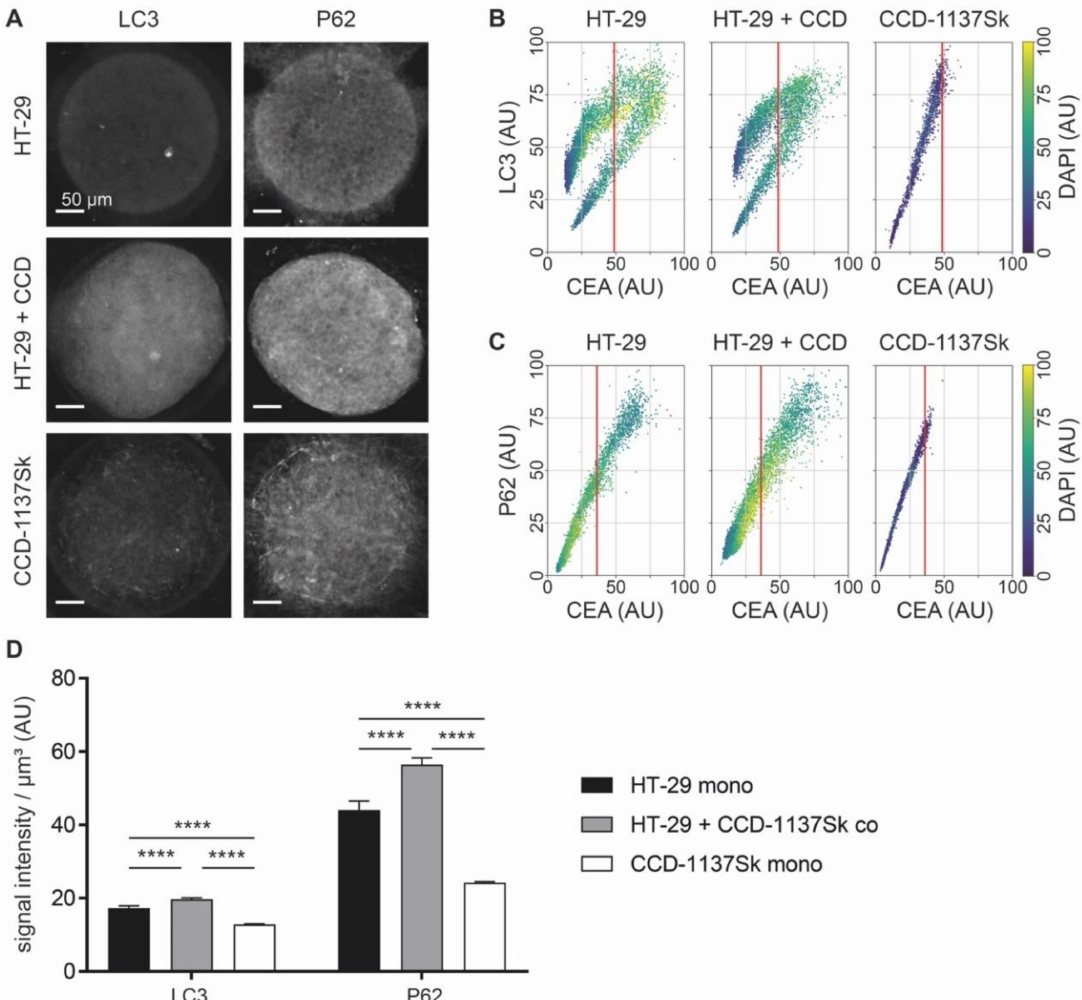
Figure 8. Co-culturing of HT-29 and CCD-1137Sk cells in Dynarrays leads to a rise of autophagic markers. A total of 4000 cells per chip cavity were seeded to yield either mono- or co-cultures of HT-29 and CCD-1137Sk cells. In the case of co-cultures, 2000 HT-29 cells were co-seeded with 2000 CCD-1137Sk cells per well. After four days, chips were fixed, cleared, and stained with DAPI and antibodies against CEA as well as LC3 or P62 as markers for nuclei, cancer cells, and autophagy, respectively. Then, samples were imaged with 3-D confocal microscopy. ( A ) Representative sum-z projections. ( B , C ) Scatter plots showing fluorescence intensity distributions of anti-LC3 ( B ) or anti-P62 signals ( C ) as a function of anti-CEA intensity for HT-29 mono-cultures (left), HT-29 + CCD-1137Sk co-cultures (middle), and CCD-1137Sk mono-cultures (right). Each dot shows the average intensity of a voxel cube of a total of five Dynarray cavities. Red vertical line, CEA brightness range that contains 95 % of all CCD-1137Sk voxel cubes in mono-culture. ( D ) LC3 / P62 fluorescence intensity per µ m 3 . Mean + SEM ( n = 5